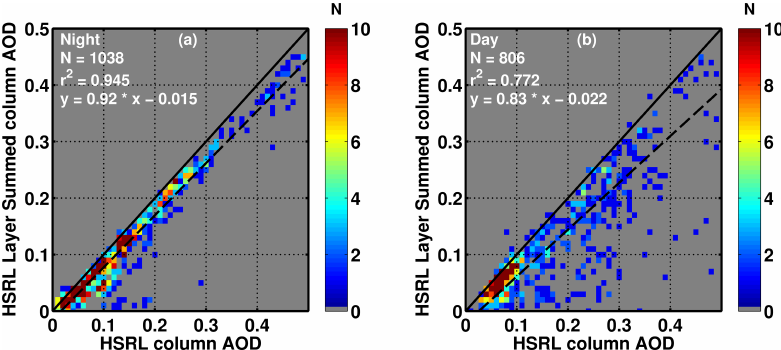
Figure 7. Night (a) and day (b) regressions of HSRL column and layer-summed AOD. The solid black line is the one-to-one line and the regression is the dotted